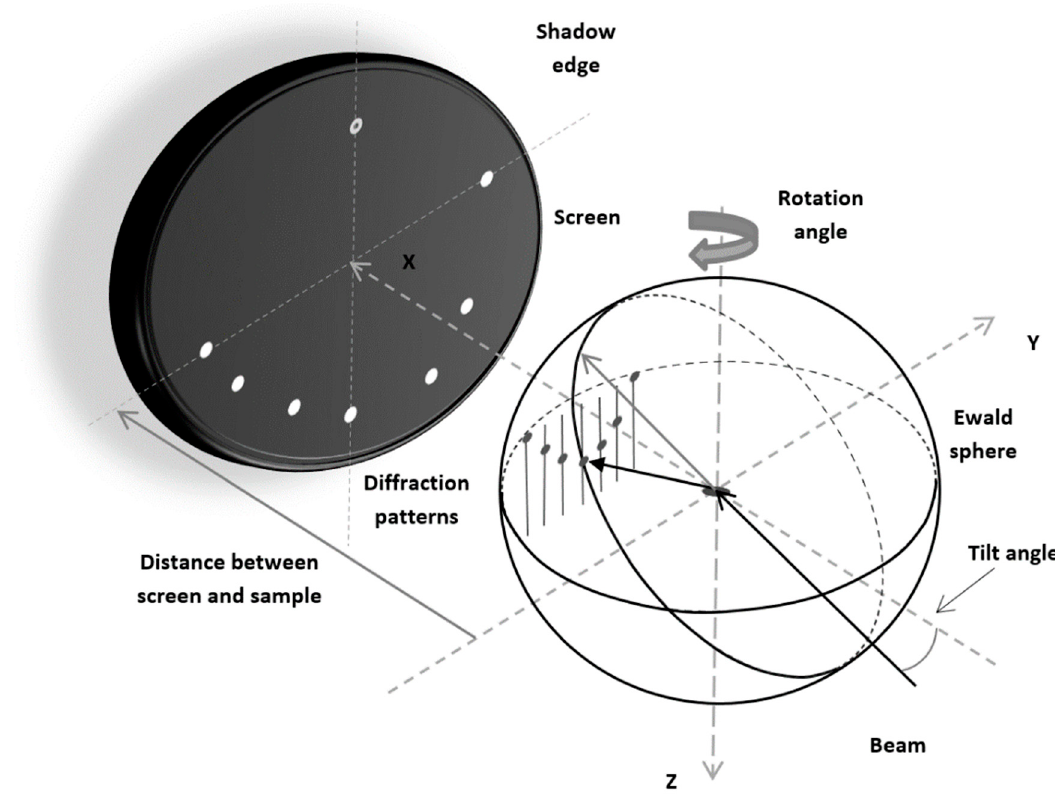
Figure 1. The Ewald construction for RHEED.